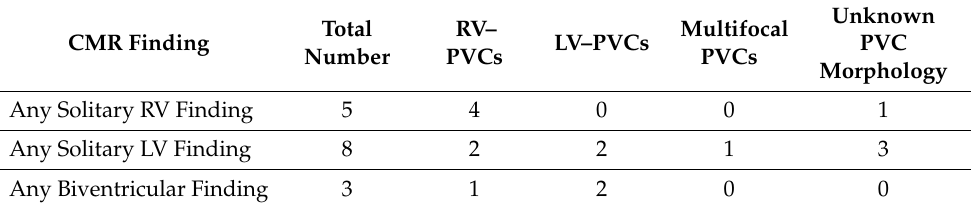
Any Biventricular